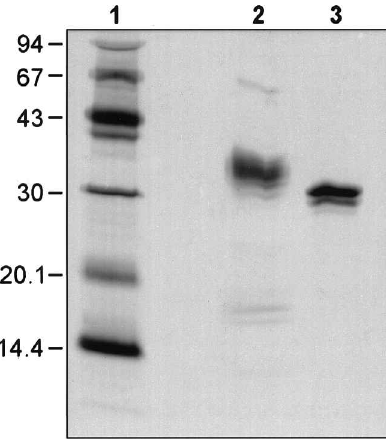
FIG. 1. SDS-PAGE analysis of gpIL-5 and hIL-5. The recombi- nant proteins were purified as described in Methods. Ali- quots of gpIL-5 (0.05 m g; lane 2) or hIL-5 (0.1 m g; lane 3) were treated with SDS sample buffer in the absence of reducing agent and then run on a 20% SDS PhastGel (PhastSystem; Amersham Pharmacia Biotech). The gel was silver stained. The bands in lane 1 represent protein standards, with corresponding Mr noted in the